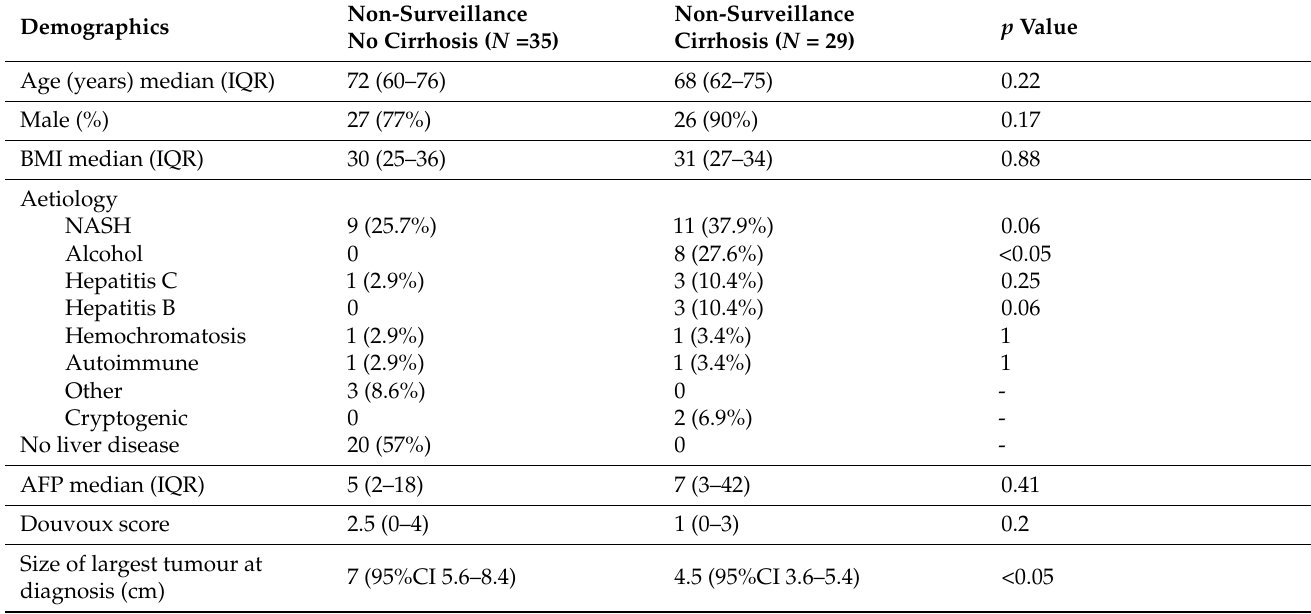
Table 2. Patient and tumour demographics with and without cirrhosis in the non-surveillance